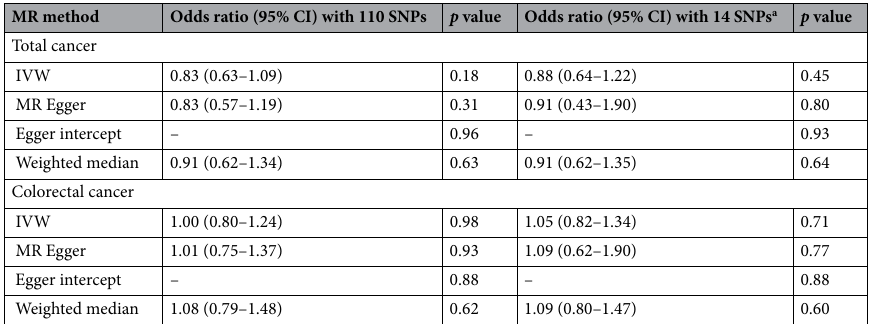
Table 3. Mendelian Randomization estimates between plasma vitamin D concentrations and total or colorectal cancer. IVW Inverse variance weighted, MR Egger Mendelian randomization egger. ORs